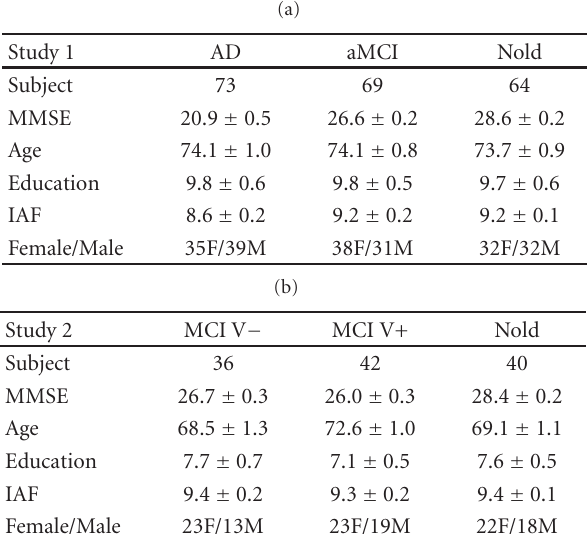
Table 1: Mean values ( ± standard error) of the demographic and clinical characteristics of the investigated